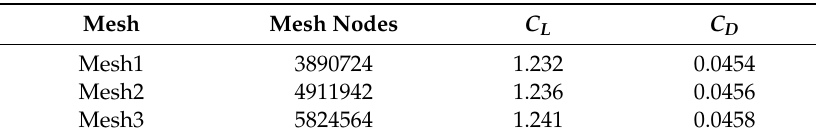
Table 1. Grid independence of the initial foil. Mesh Nodes C L